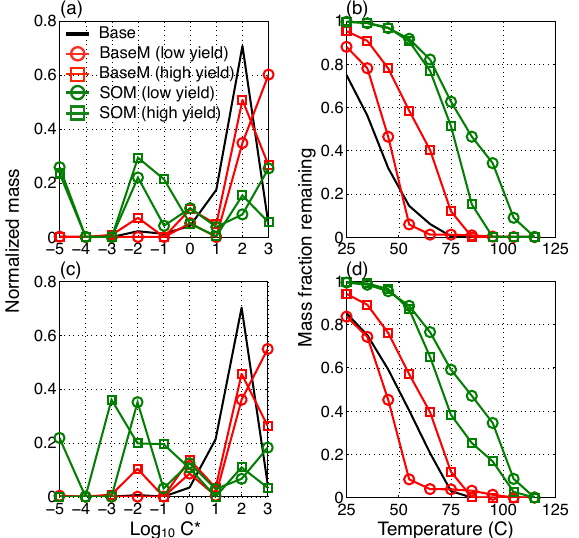
Figure 3: Volatility distributions of the 14-day averaged gas+particle SOA mass at Los Angeles (a) and Atlanta (c) for the Base, BaseM and SOM simulations. Thermograms that capture the volatility of the 14-day averaged gas+particle SOA mass at Los Angeles (b) and Atlanta (d) for the Base, BaseM and SOM simulations.